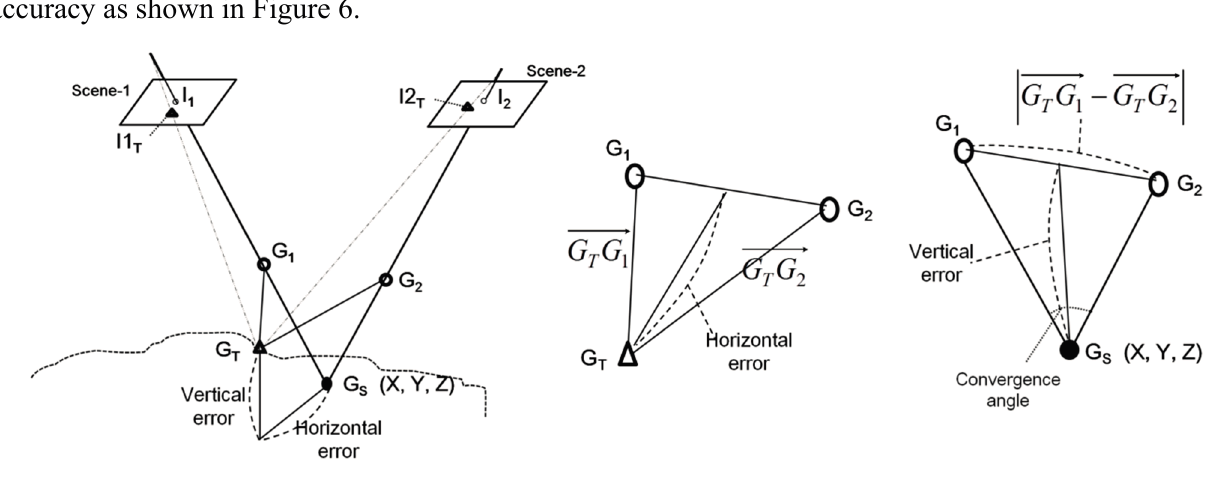
Figure 6. Relationship between pointing error vectors of individual image and 3D position